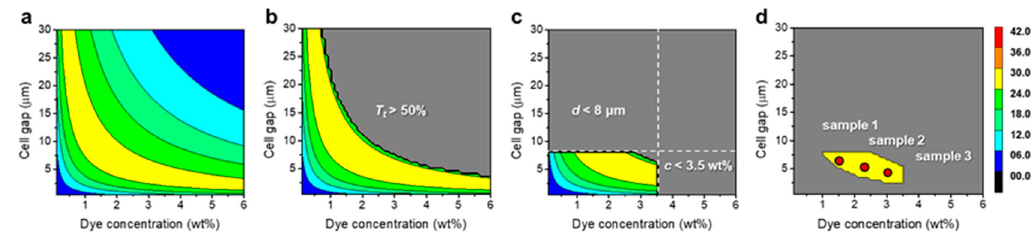
Figure 6. An example of the proposed design process for an ECB cell on a constant transmittance-difference contour map. ( a ) The constant transmittance-difference contour map of an ECB cell. ( b ) The region that does not satisfy the minimum transmittance in the transparent state is excluded. ( c ) The regions that do not satisfy the conditions of the cell gap and dye concentration are excluded. ( d ) The regions that do not satisfy the minimum transmittance difference are excluded. The red dots represent the fabrication condition for the 3 samples.